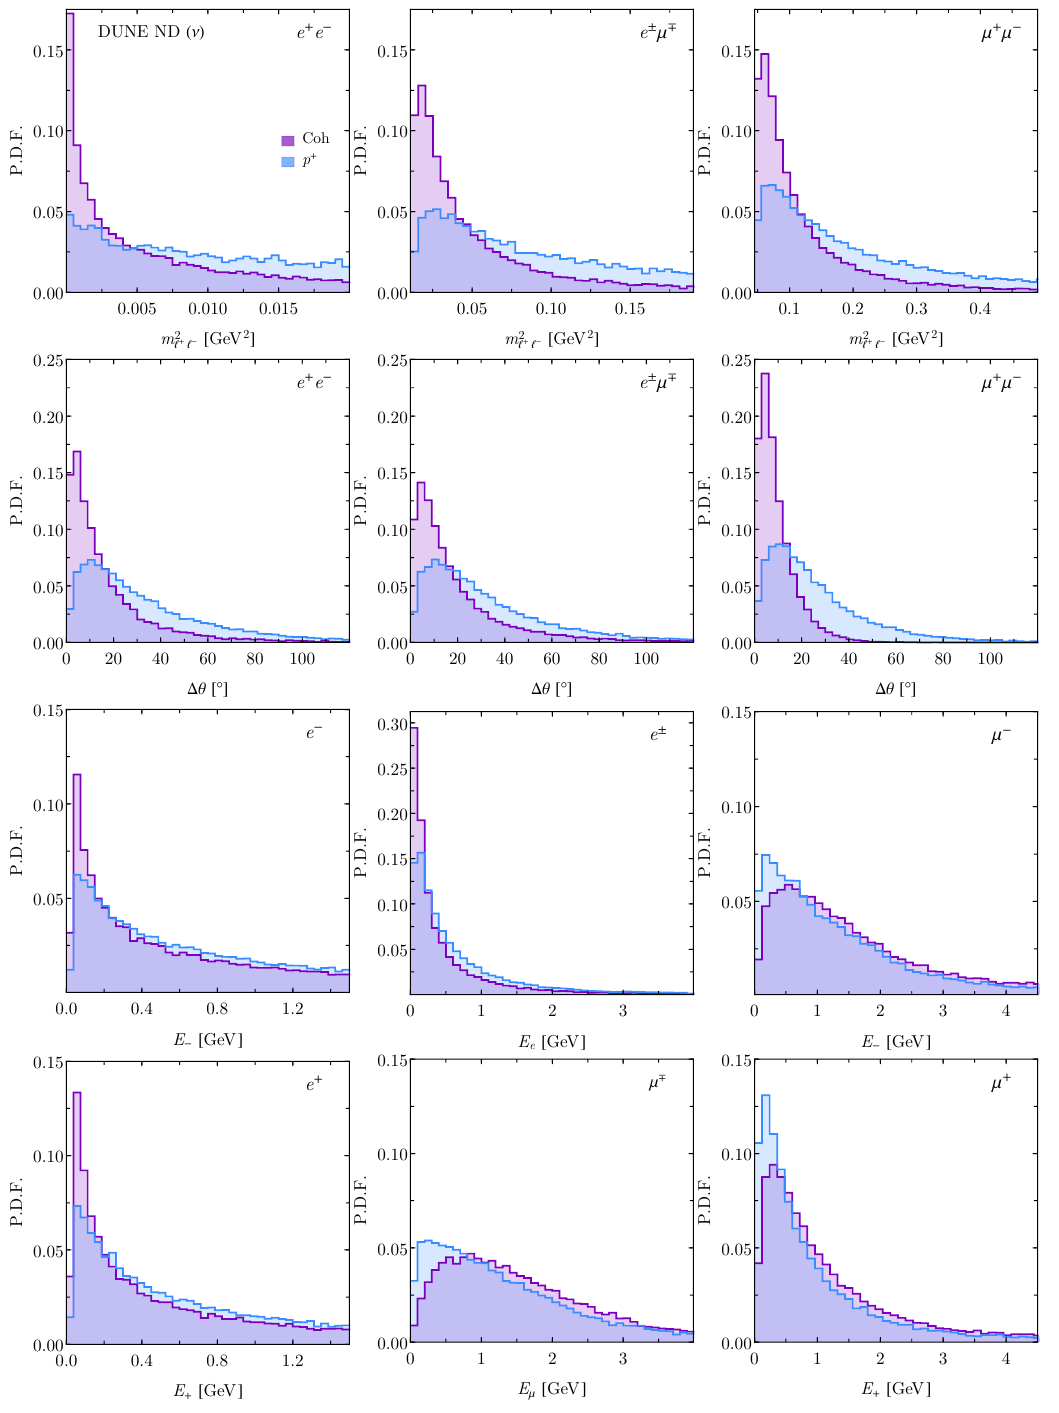
Figure 8 . Flux convolved neutrino trident production distributions for DUNE ND in neutrino mode. In purple we show the coherent contribution in 40 Ar and in blue the di(cid:11)ractive contribution from protons as targets only (including Pauli blocking). The coherent and di(cid:11)ractive distributions are normalized independently. The relative importance of each contribution as a function of E (cid:23) can be seen in (cid:12)gure